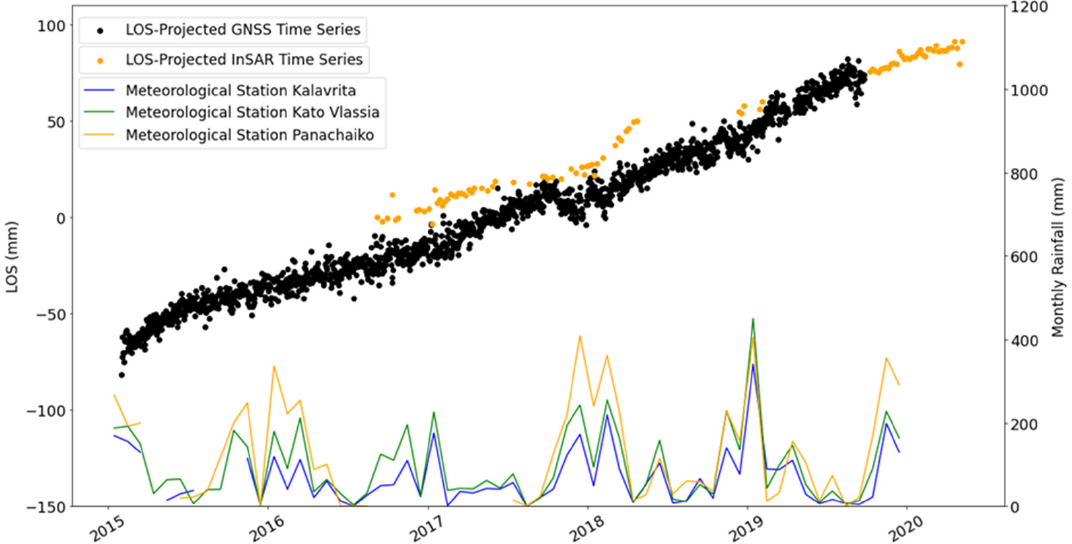
Figure 9. LOS-Projected GNSS time series (KRIN station: black points) and InSAR position time series (orange points: descending orbit) of the pixel which contains the GNSS station. Also, blue, green and orange lines represent the rainfall of the meteorological stations Kalavrita, Kato Vlassia and Panachaiko (see Figure 1 for station localities).